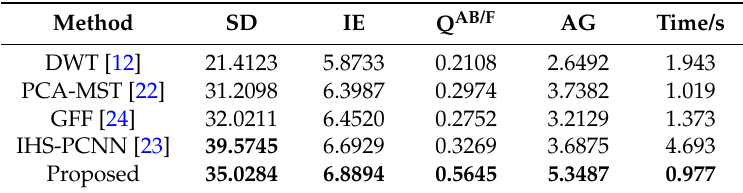
Table 2. Evaluation of Quad IR-visible image fusion